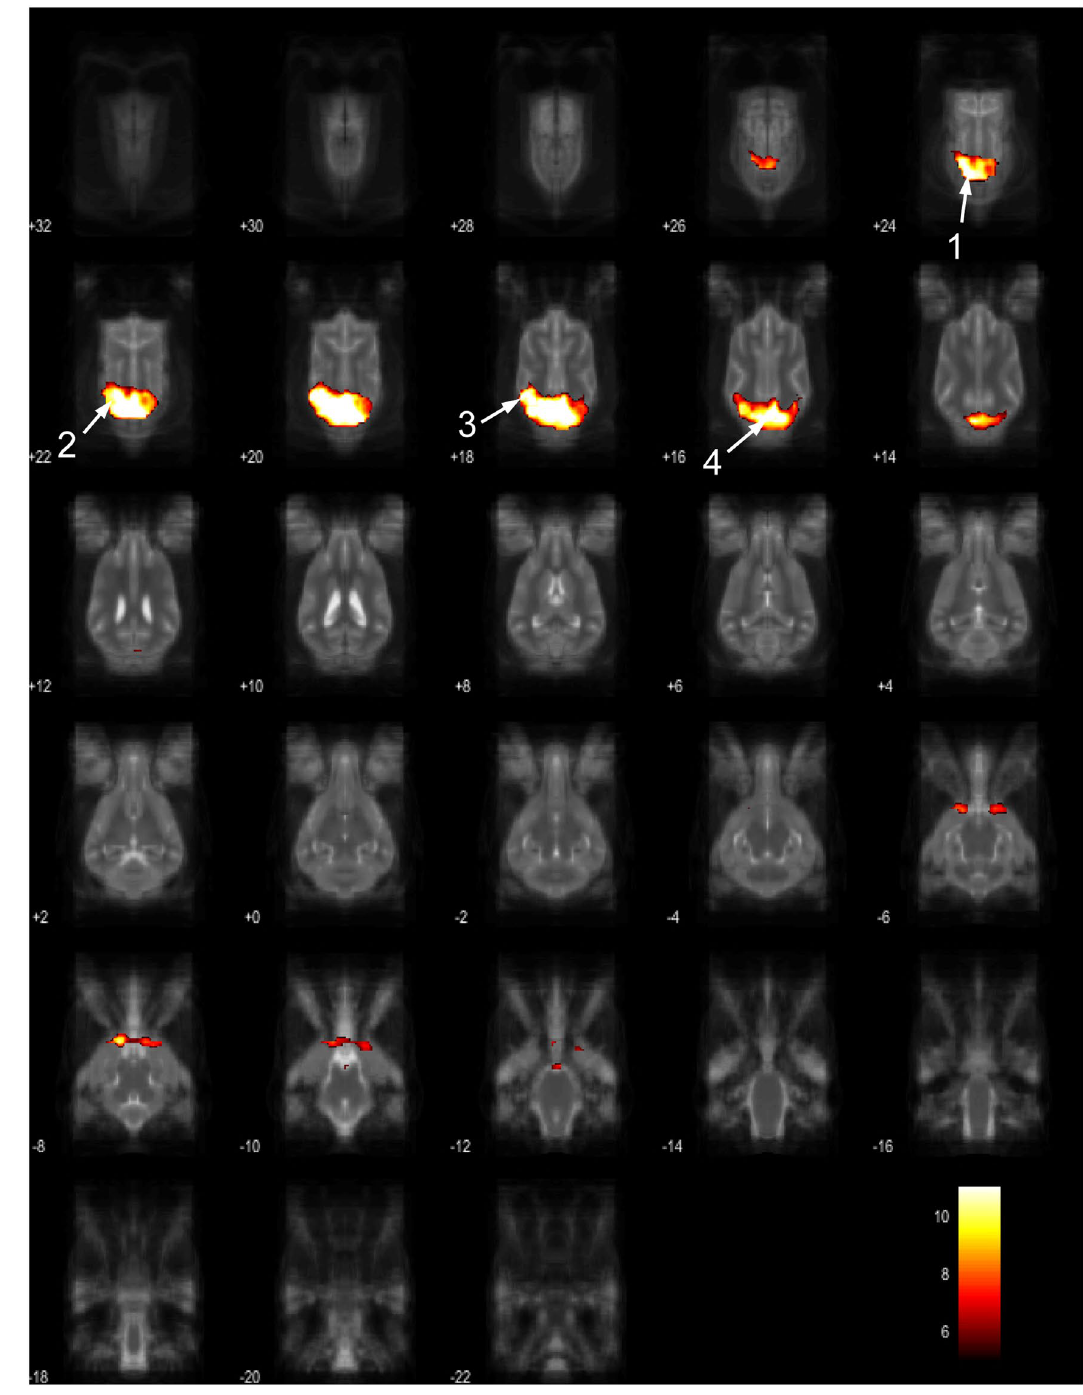
Figure 15. Resting-state network component L from the 15 component gICA. We report the results with a voxel-wise FDR corrected p < 0.001 and cluster treshold of FDR corrected p < 0.005. gICA components are presented as thresholded T-maps, corrected for multiple comparisons, overlaid on the Nitzsche atlas 15 . 1. marginal gyrus, 2. ectomarginal gyrus, 3. suprasylvian gyrus, 4. occipital